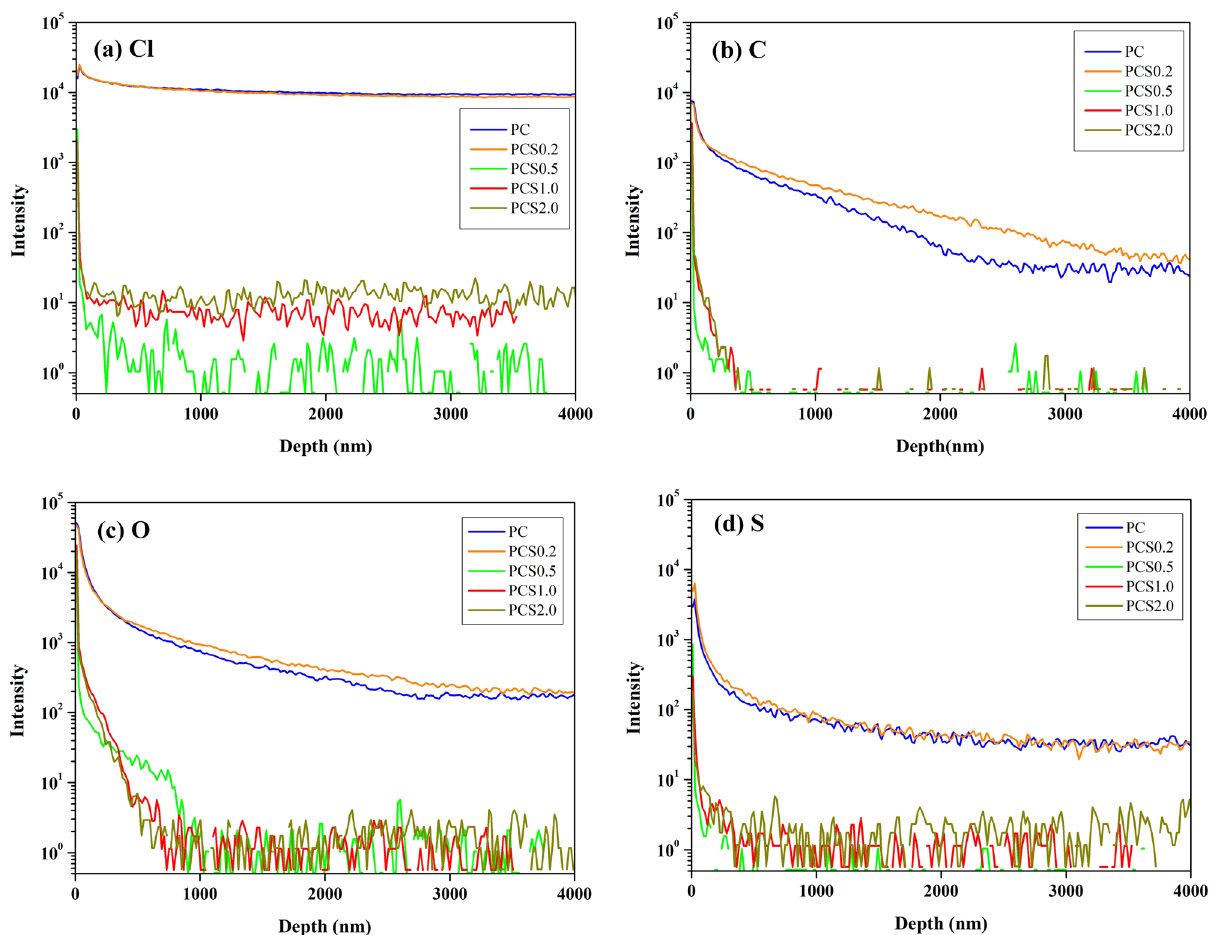
Figure 7. SIMS intensity of ( a ) Cl, ( b ) C, ( c ) O, and ( d ) S as a function of detection depth in the Cu electroplated layers labelled as PC–PCS2.0.